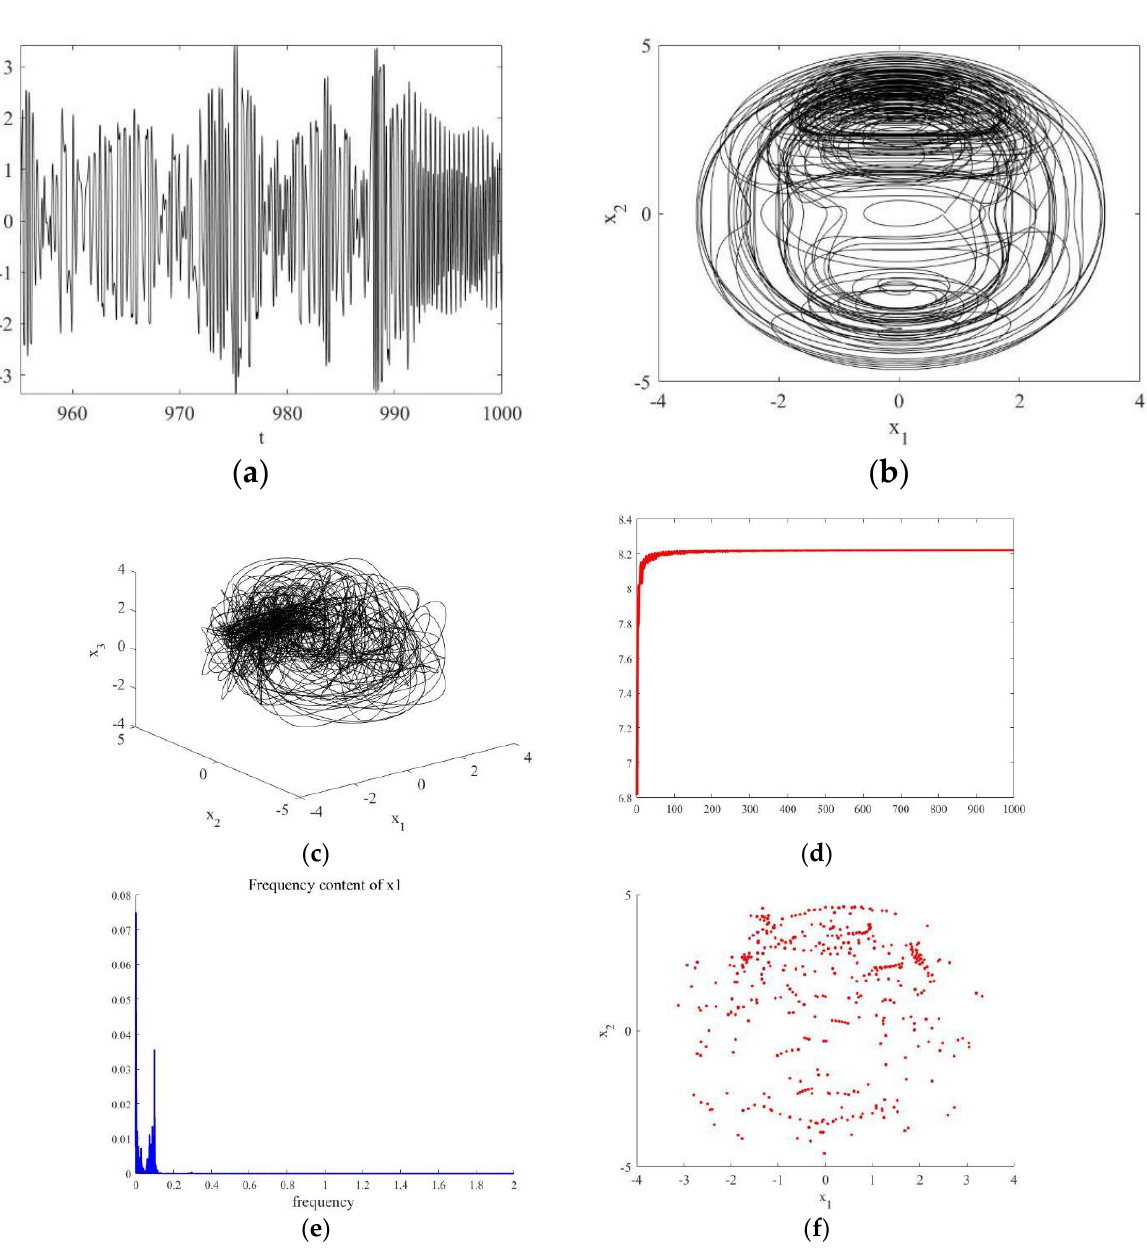
40 F = Figure 14. The trajectory under the condition 3 . ( a ) The waveform on the plane ( t , 1 Figure 14. The trajectory under the condition F 3 = 40. ( a ) The waveform on the plane ( t , x 1 ). ( b ) The phase portrait on the plane ( x 1 , x 2 ). ( c ) The phase portrait in the three-dimensional space ( x 1 , x 2 , x 3 ). x x ( b ) The phase portrait on the plane ( 1 , 2 ). ( c ) The phase portrait in the three-dimensional space ( d ) The Maximum Lyapunov exponent plot of x 1 . ( e ) The power spectrum of x 1 . ( f ) The Poincare x x x x ( 1 , 2 , 3 ). ( d ) The Maximum Lyapunov exponent plot of 1 . ( e ) The power spectrum of 1 map on the plane ( x 1 , x 2 x x ( f ) The Poincare map on the plane ( 1 , 2 ).